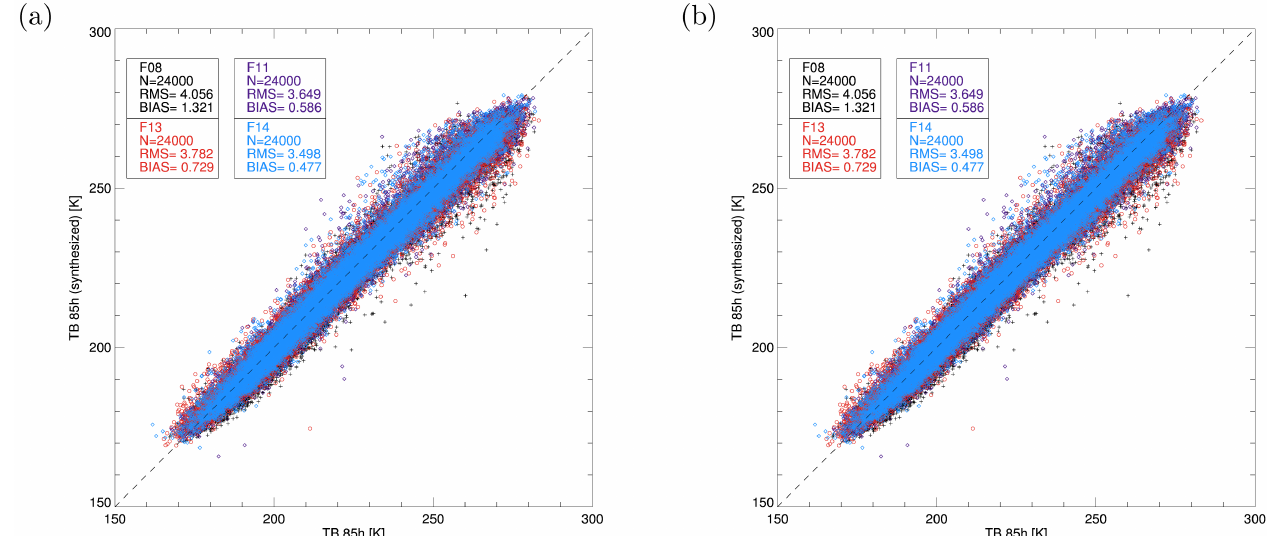
Figure 9. Comparison of random samples of synthesized TBs against original TBs of the 85GHz channel in vertical polarization (a) and horizontal polarization (b) for the SSM / Is on DMSP F08 (1987), F11 (1998), and F13, F14